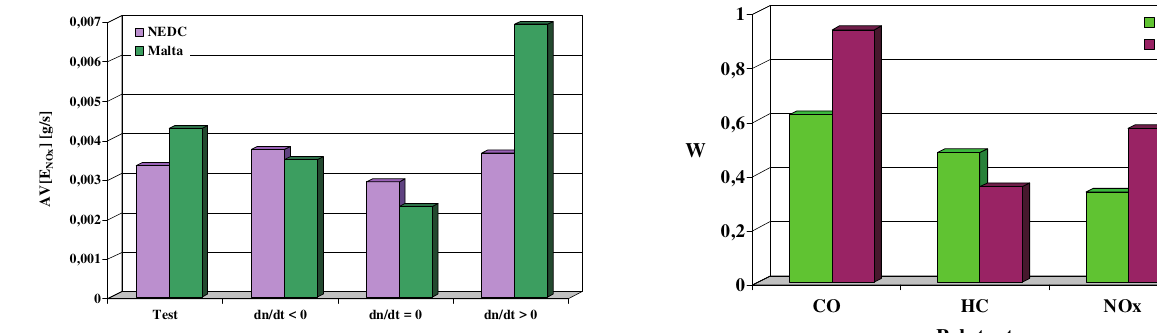
Fig. 31. Comparison of the mean nitrogen oxides emission value in the test and in the states corresponding to the negative, zero and positive values of Fig. 34. The coefficient of variation of the average emission intensity the engine speed derivative with respect to time – for the NEDC and Malta value in individual elementary states of dynamic engine torque tests